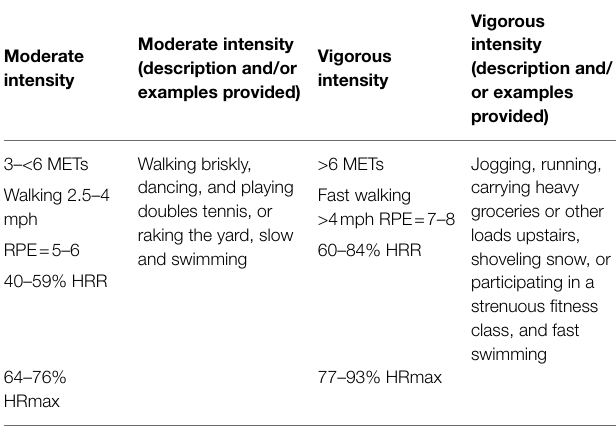
TABLE 1 | Methods commonly used to prescribe moderate to vigorous intensity